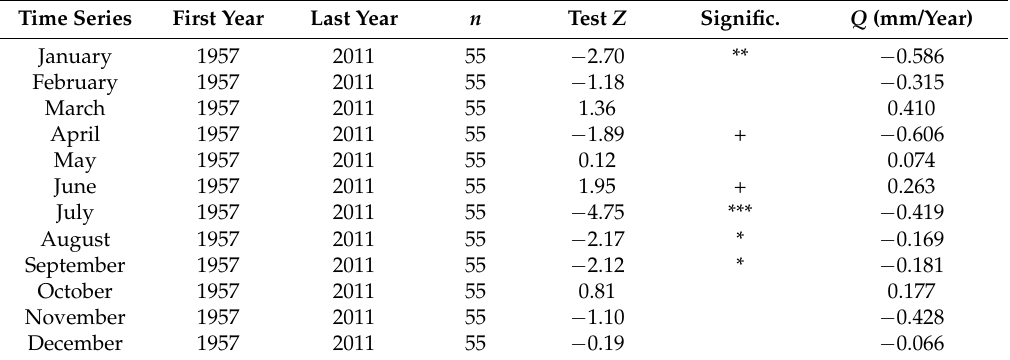
Table 2. Mann-Kendall trend and Sen’s slope for Dar es Salaam’s monthly moving average rainfall trend.